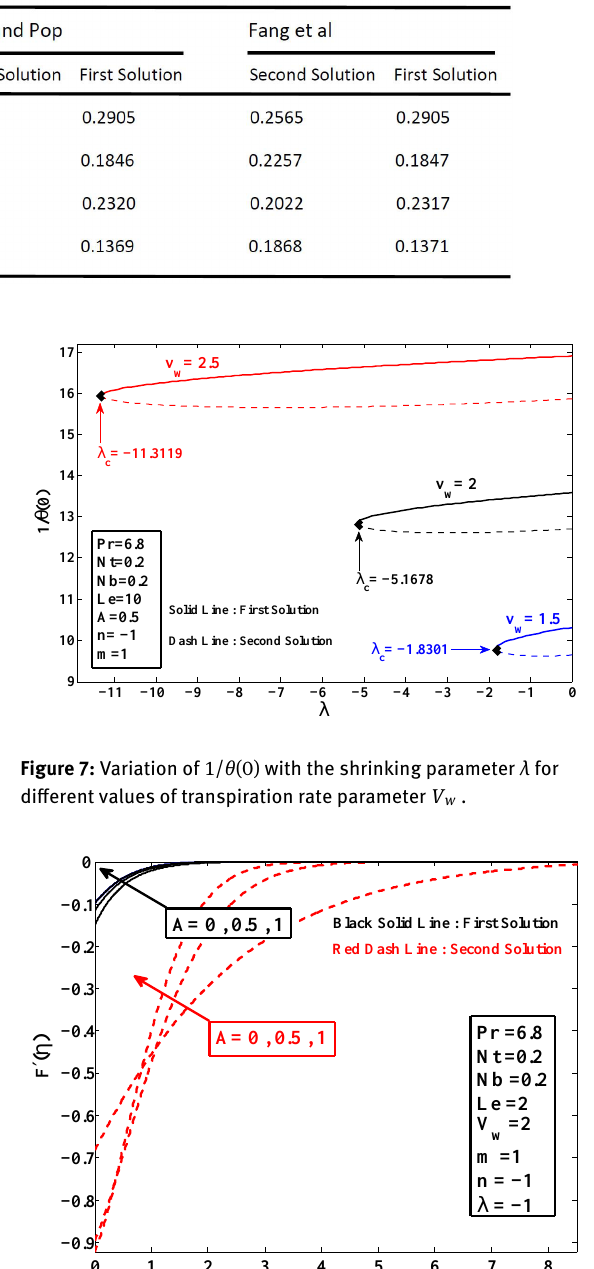
Figure 6: Variation of f (cid:48)(cid:48) (0) with the shrinking parameter λ for differ- ent values of transpiration rate parameter V w .